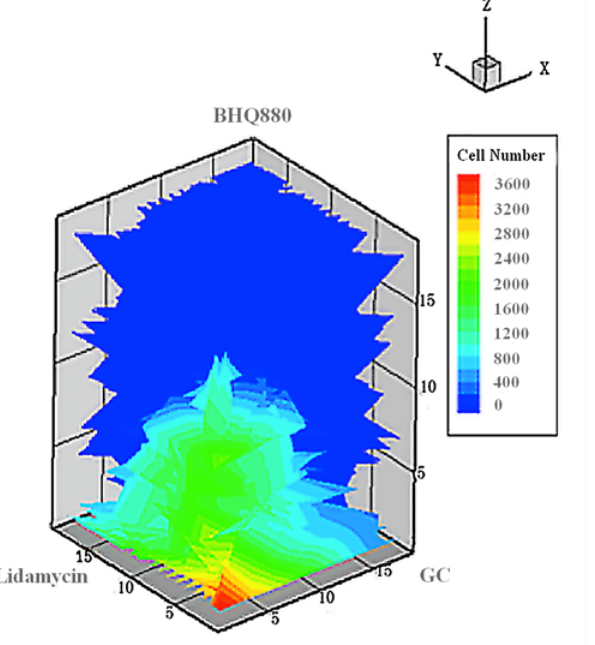
Fig 16. The effects of BHQ880, GCs and Lidamycinon restoring the balance between OCs and OBs and killing MMs.